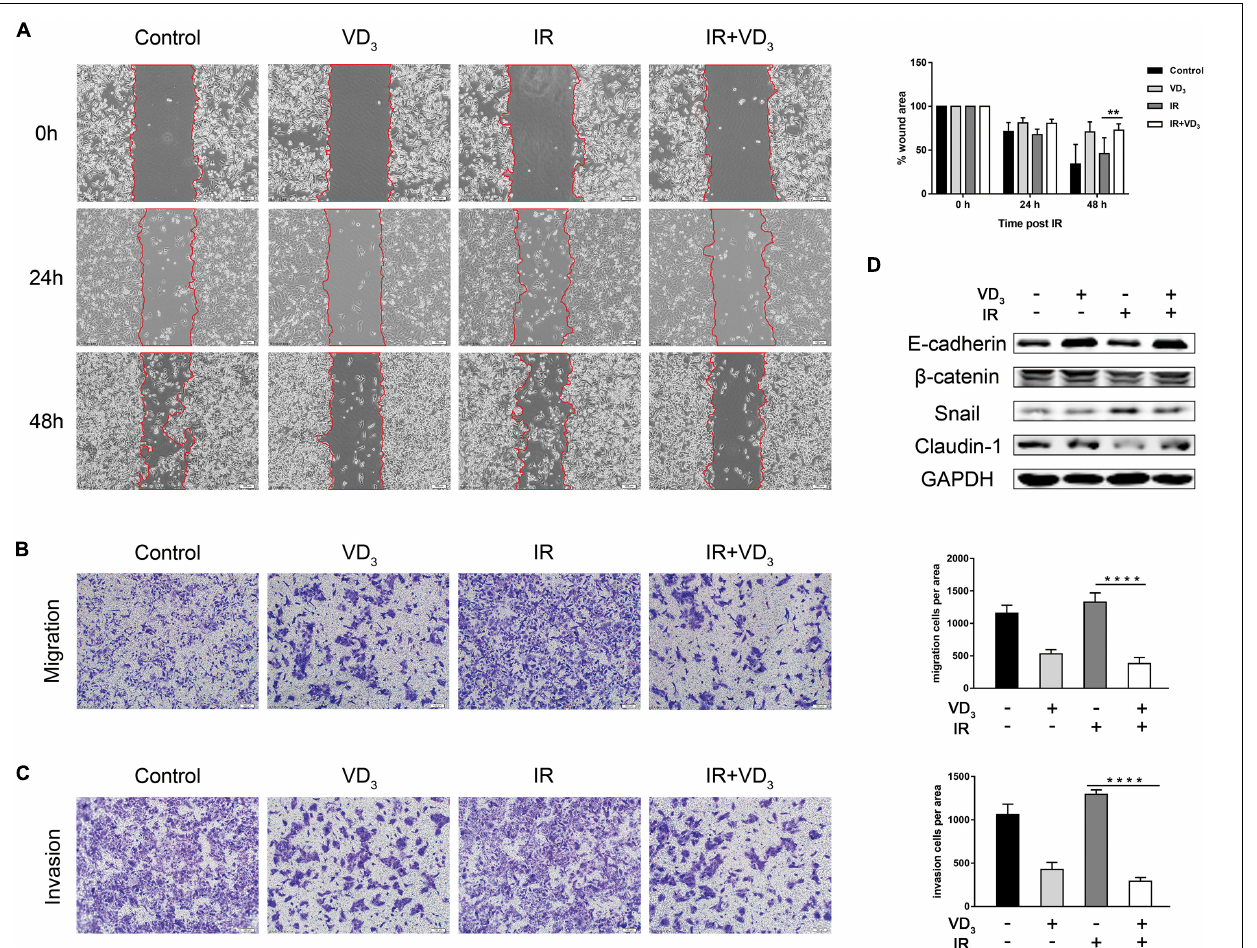
FIGURE 3 | VD 3 inhibited EMT in combination with IR. (A) Cell migration rates of the four groups was measured by the wound-healing assay. Images of wound closure were taken at 0, 24, and 48 h after scratching the cell layer. Scale bar: 100 µ m. (B,C) Migration and invasion of treated cells were evaluated by transwell assays. Scale bar: 100 µ m. Cellular migration and invasion were plotted as the average number of cells in three different fields. (D) Representative expression of EMT markers determined by western blot. **p < 0.01, ****p <